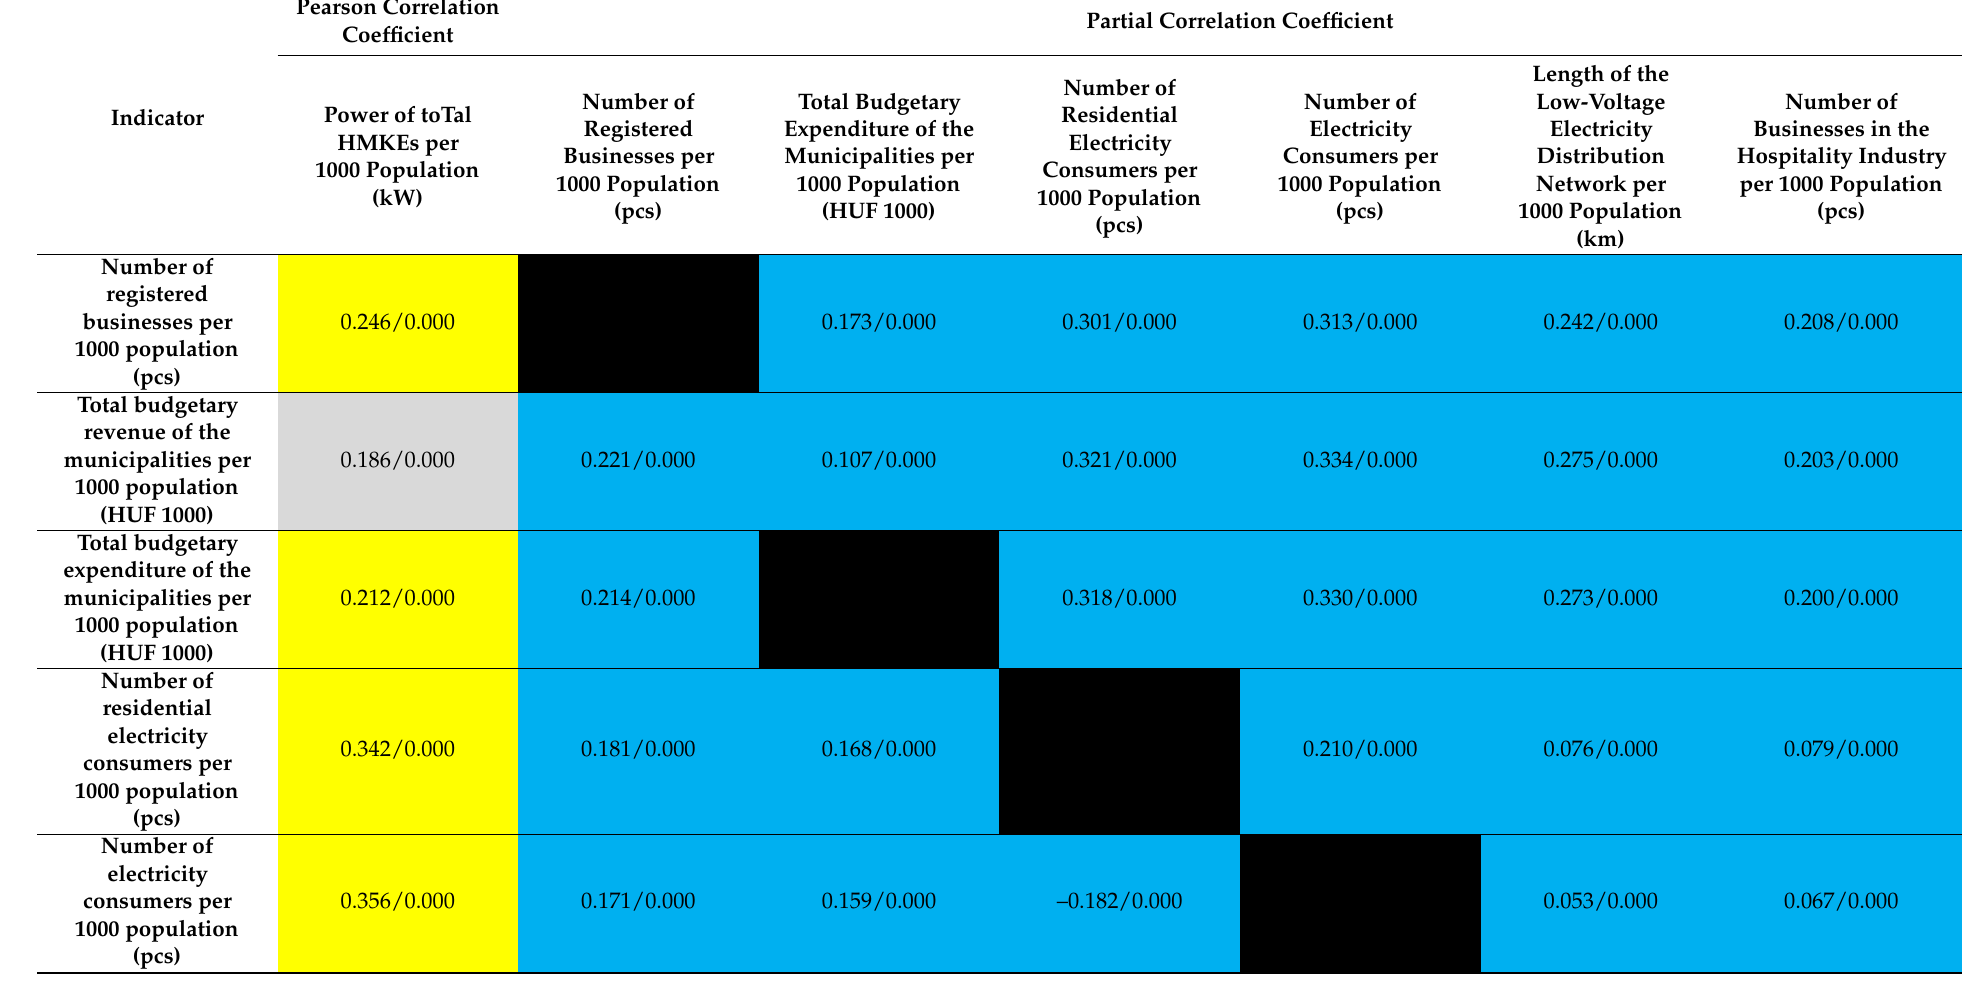
Table 6. The strengths of the relationships between the power of the total HMKE per 1000 population and the settlement indicators 1 ( 1 Pearson correlation coefficient/ p -value; if p < 0.05, then there is a significant verified relationship between the two variables) (in the case of the Pearson correlation coefficients in the table grey background indicates weak correlations and yellow means weak moderate ones.) In the case of the partial correlation the blue background signals partial explanation (the controlled variable explains the relationship between variables i and j only partially), while the black one shows irrelevant